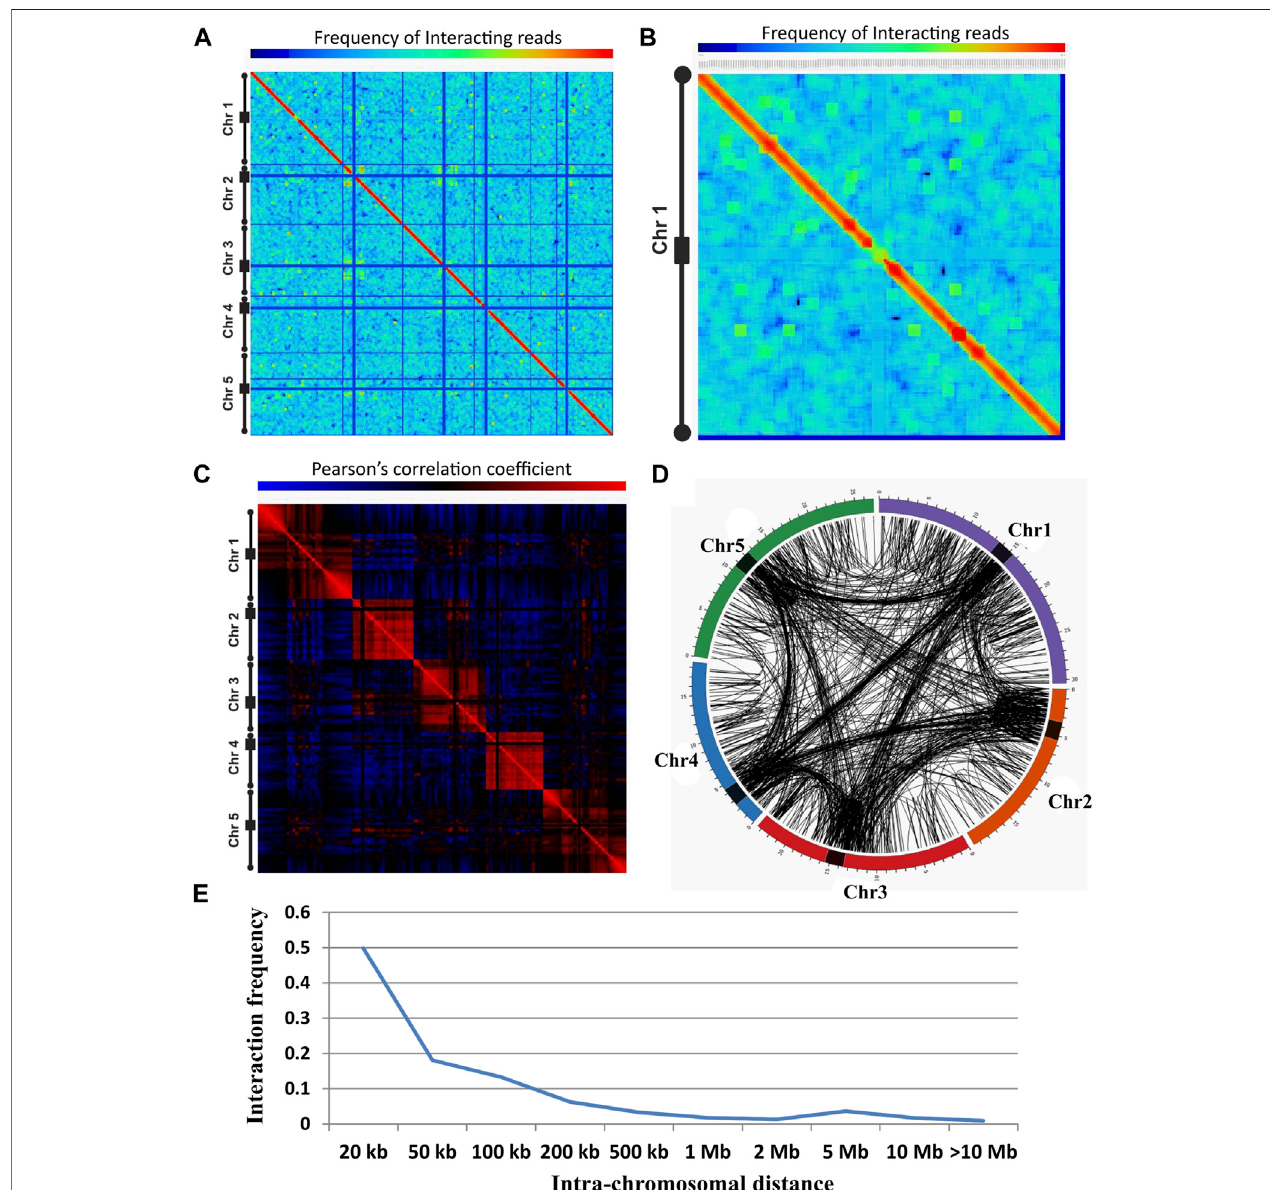
FIGURE 1 | Chromatin interactions landscape in A. thaliana . (A) Genome-wide normalized interaction matrix at 200 kb resolution for Arabidopsis genome (NC), showingintensereddiagonalrepresentingtheenrichment ofinteractingreads incloseproximity.Bluelinerepresentsreadsthatarelessenrichedinthecentromericand telomericregionofthegenome.Thecolorbarrangingfrombluetoredrepresentsthelowertohigherenrichmentofinteractingreads.The fi vedifferentchromosomesare indicatedwithablackline,inwhicharectangularboxrepresentsthepericentromericandcirclesrepresentthetelomericregionofthechromosome. (B) Normalized interaction matrix for chromosome 1 showing several spots of enriched interacting reads in the genome indicating the presence of long-distance chromatin-chromatin interactions. (C) Genome-wide correlation interactionmatrixrepresentingthecorrelation amongtheinteracting regionofHTlibrary. Thered colorrepresents thepositive correlation and the blue color represents the negative correlation between the two regions. Correlation matrix suggests two distinct regions of the genome showing positively correlated interacting regions and negatively correlated non-interacting regions. (D) Circos representing the genome-wide identi fi ed signi fi cant interaction of NClibrary.Interactionswererepresentedinthechromosomesthroughtheblacklineconnectingthetwopoints(interactingregions).Spansthatlinktheregionswithinthe chromosome represent cis interactions while spans that link the regions between the chromosomes represent trans interactions. The outermost colored circle is the graphical representation of Arabidopsis chromosomes and the black rectangular box on it represents the centromeric region of each chromosome. Chromosome numbers are indicated after the chromosome (Chr) abbreviation. (E) Plot showing the relationship of interactions frequency with the linear physical distance along the chromosome for NC library. Intra-chromosomal interaction frequency decreases with increasing linear distance on the chromosomes.